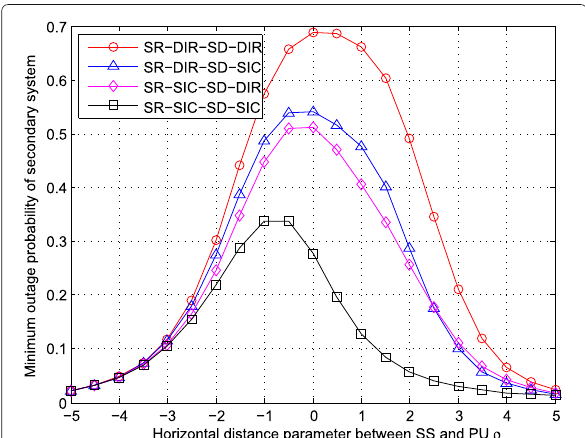
Fig. 12 Minimum outage probability of secondary system vs the distance factor ρ